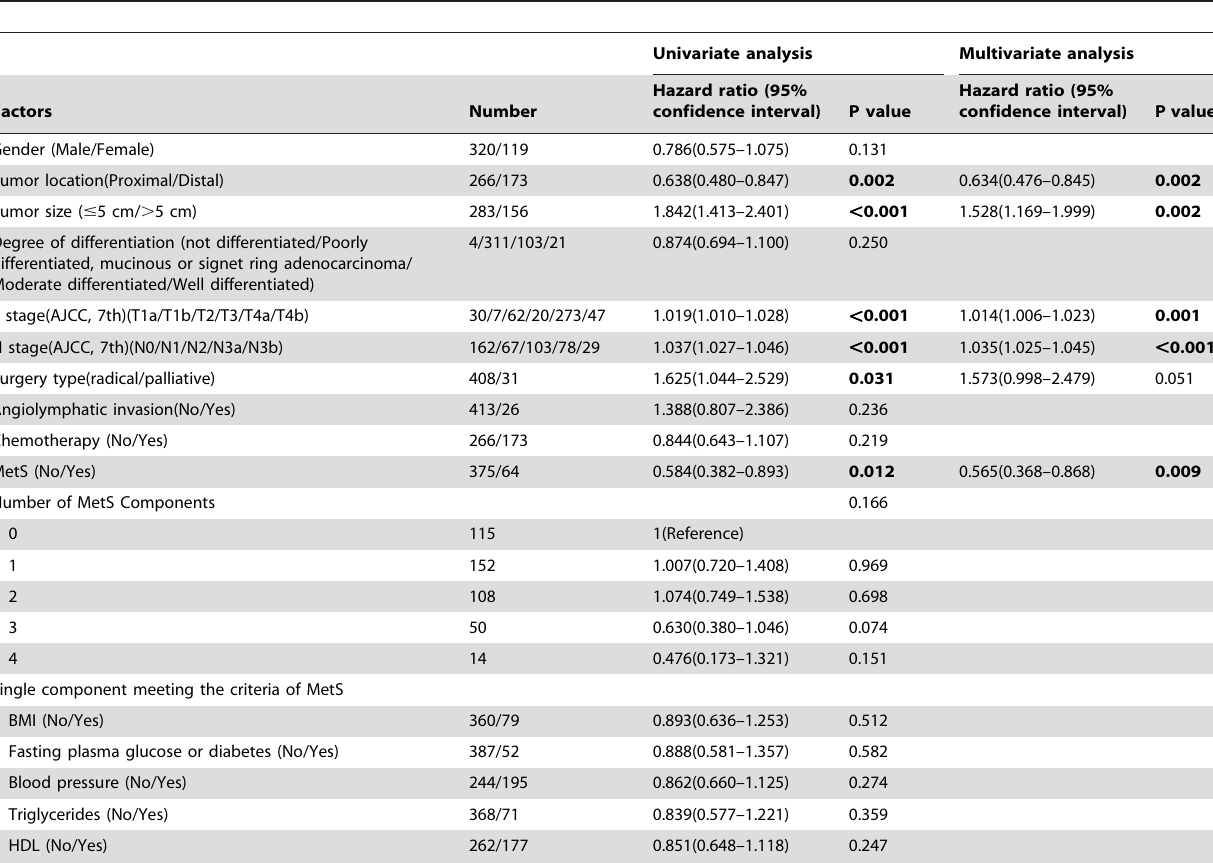
Table 2. Association between metabolic syndrome (MetS) and its components and overall survival in old patients (age § 50 y) in a univariate and multivariate